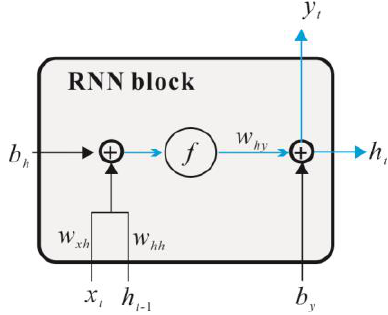
Figure 3. Simple RNN cell structure in hidden layer (b).